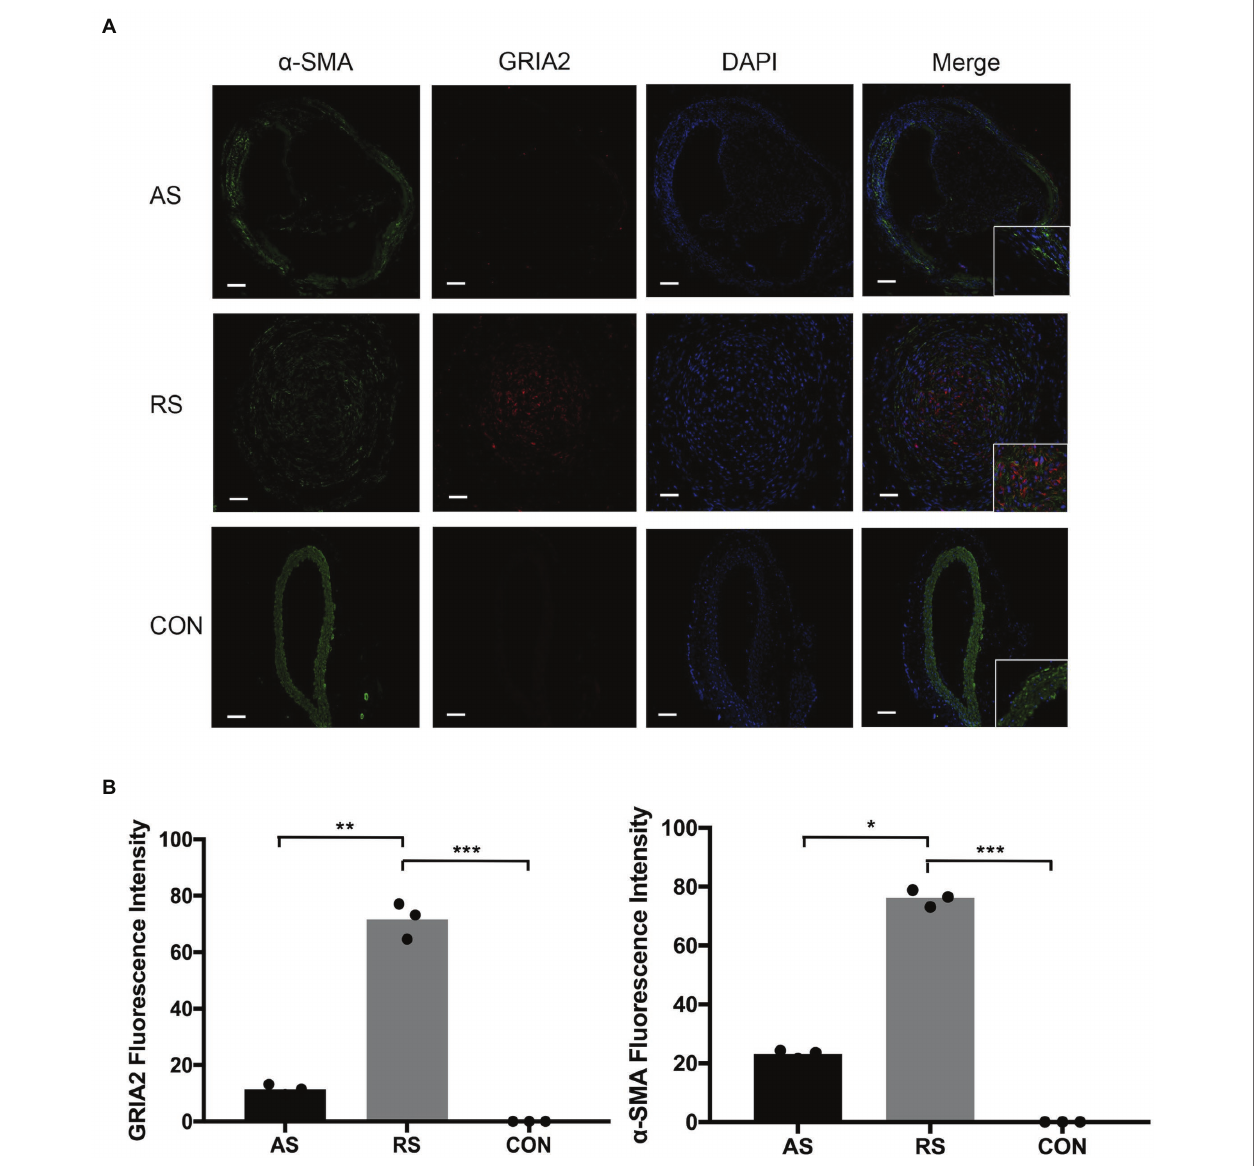
FIGURE 2 | GRIA2 is highly expressed in VSMCs in restenosis. (A) Double immunofluorescence staining of GRIA2 (red) and VSMCs (green, stained with α -SMA ) in restenotic plaque tissues, atherosclerotic plaque tissues and healthy control artery tissues is shown ( n = 3). Intensity of fluorescence is the statistical calculations in the intima. Images are representative, and (B) the bar graph shows the average data of three independent experiments ( n = 3). Staining was performed at 100 × magnification; the right part of the picture was magnified to 200× (scale bar, 50 μ m). AS: atherosclerotic; RS: restenotic; CON: control; VSMCs: vascular smooth muscle cells. *Statistically significant difference (p < 0.05); **Statistically significant difference (p < 0.01); ***Statistically significant difference (p <